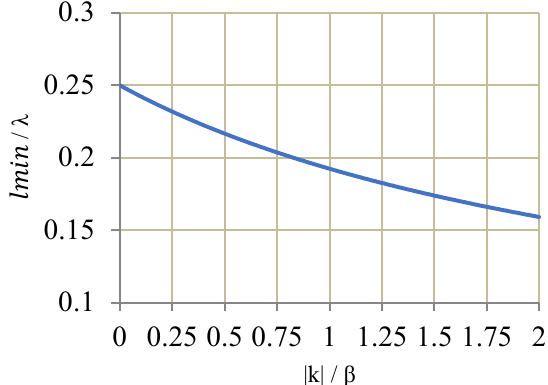
Figure 1. Minimum length of short-circuited ETTL shunt resonator.